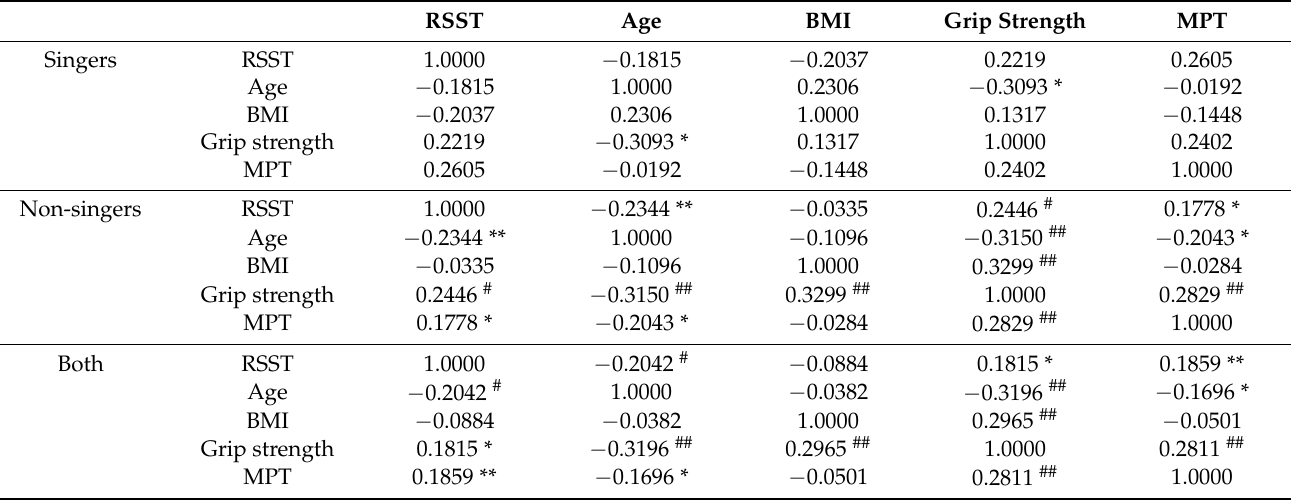
Table 2. Correlations between parameters associated with swallowing ability.